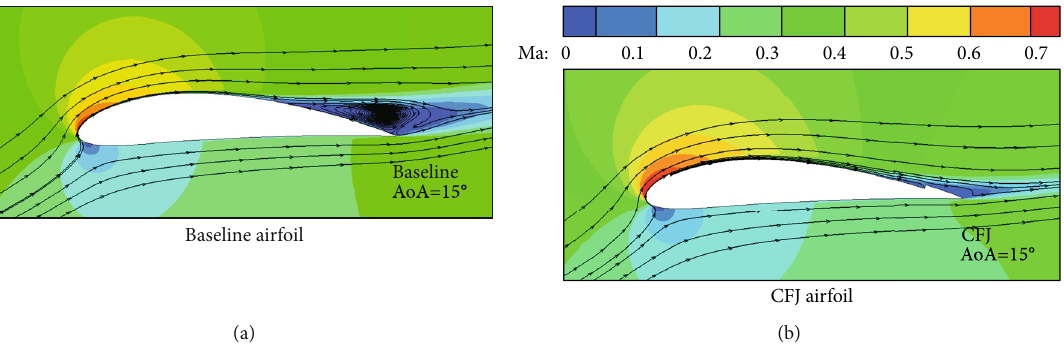
Figure 5: Mach number contours and streamlines of the NACA6415 baseline and CFJ airfoils ( AoA = 15 ° ).